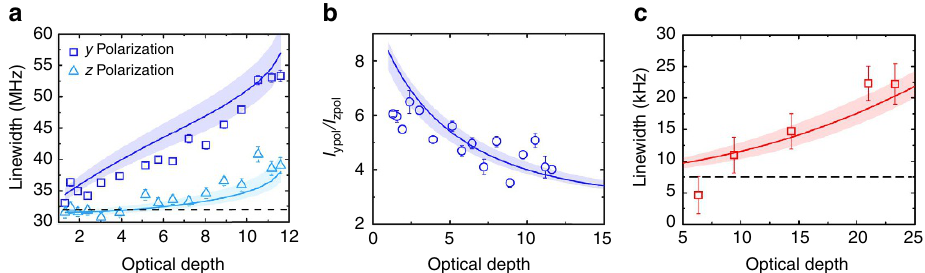
Figure 3 | Transverse scattering. ( a ) Linewidth broadening for the blue transition in the transverse direction for ^ y polarization (open squares) and ^ z polarization (open triangles). ( b ) Intensity ratio, I ypol / I zpol , of ^ y polarization to ^ z polarization measured in the transverse direction when a blue probe beam is used. For low optical depths single particle scattering is dominant and for single particle scattering almost zero intensity is predicted for ^ z -polarized fluorescence, as this polarization points directly into the detector. ( c ) Linewidth broadening for the red transition in the transverse direction for ^ y -polarized light, showing a similar trend to the blue transition. This transition is more sensitive to magnetic fields; thus, a large magnetic field is applied to probe only the m ¼ 0 to m ’ ¼ 0 transition. All solid curves are based on the full theory of coupled dipoles and the band in a , b and c is for a ± 20% atom number uncertainty. All error bars are for statistical uncertainties.